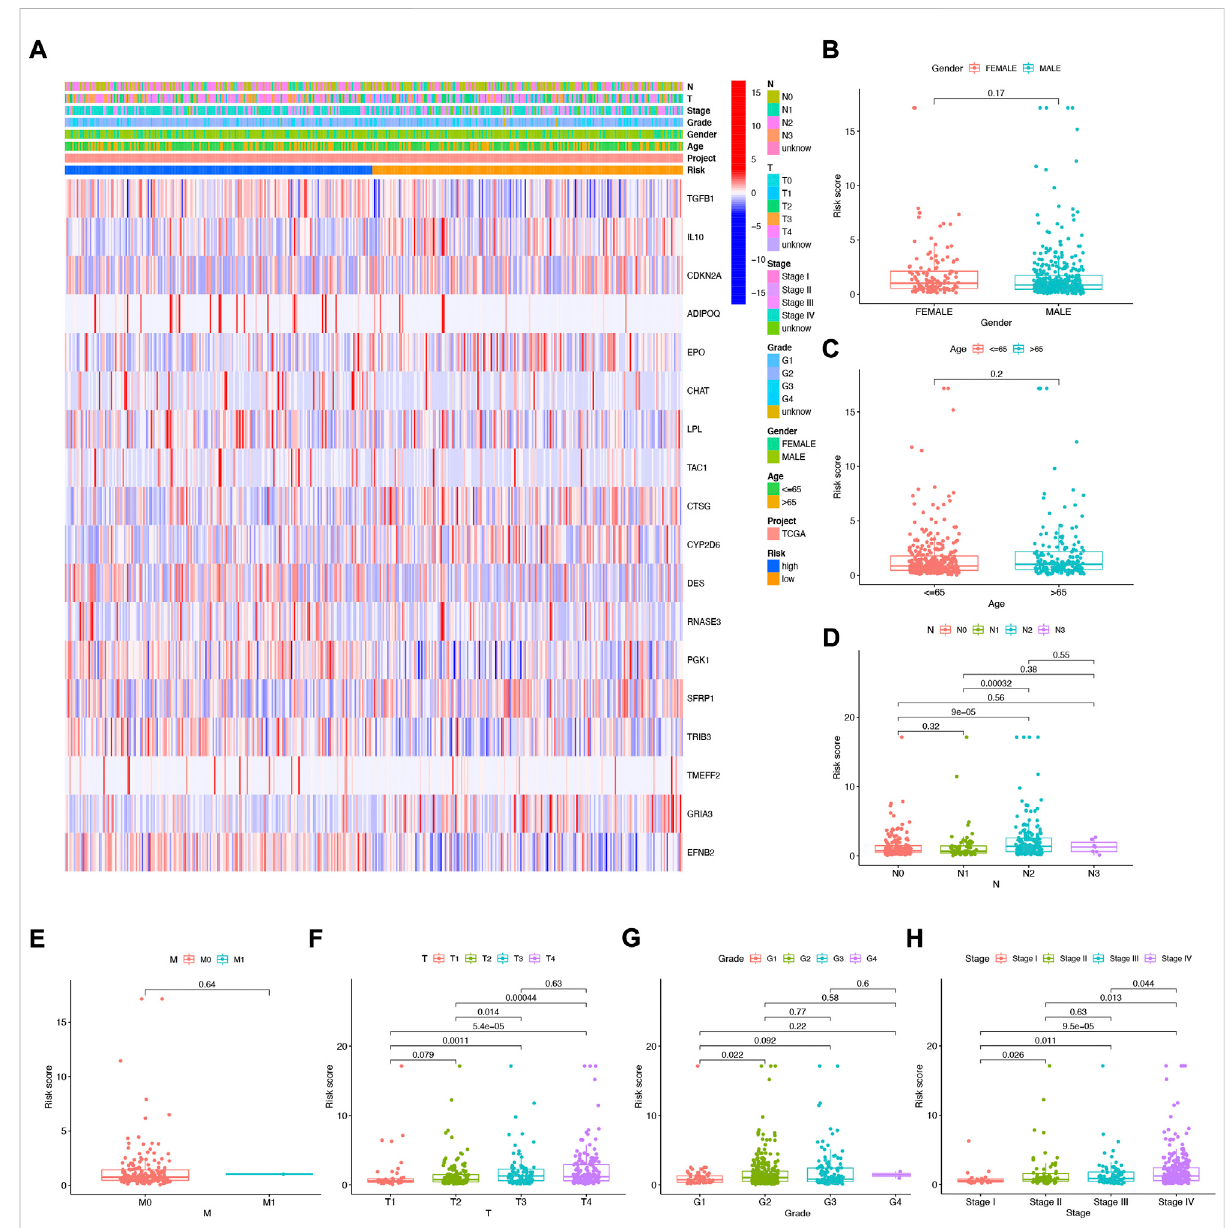
FIGURE 6 Correlation analysis of risk scores and clinicopathological features and signatures based on 18 NFRGs (A) heat maps (B) gender, (C) age, (D) N stages, (E) M stages, (F) T stages, (G) tumor grades, (H) pathological